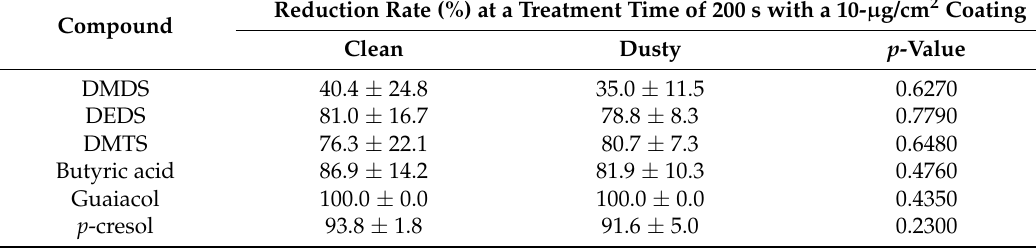
Table 8. Effect of swine dust cover on catalyst performance.